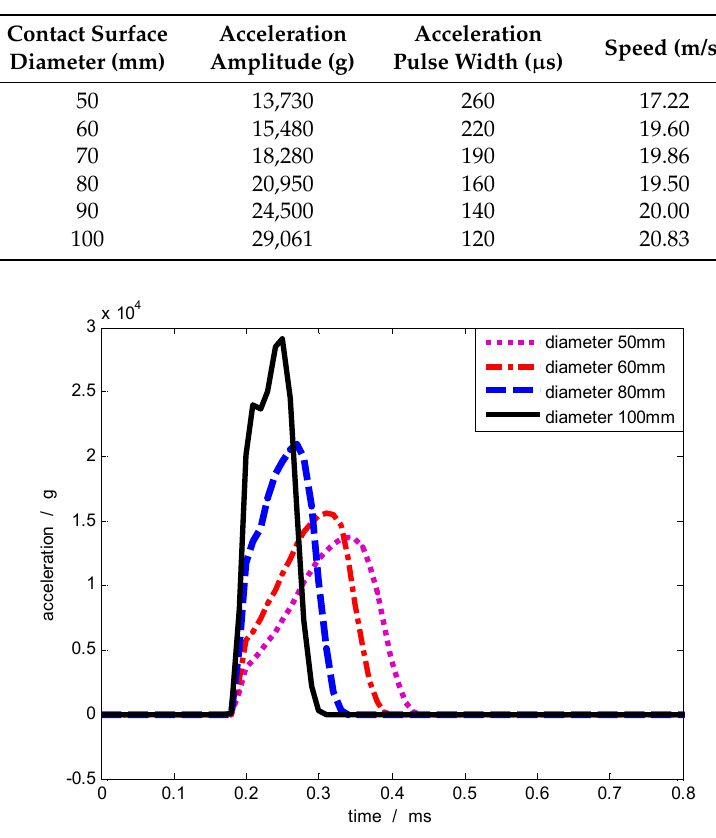
Figure 9. Acceleration pulse waveforms generated by different contact areas.